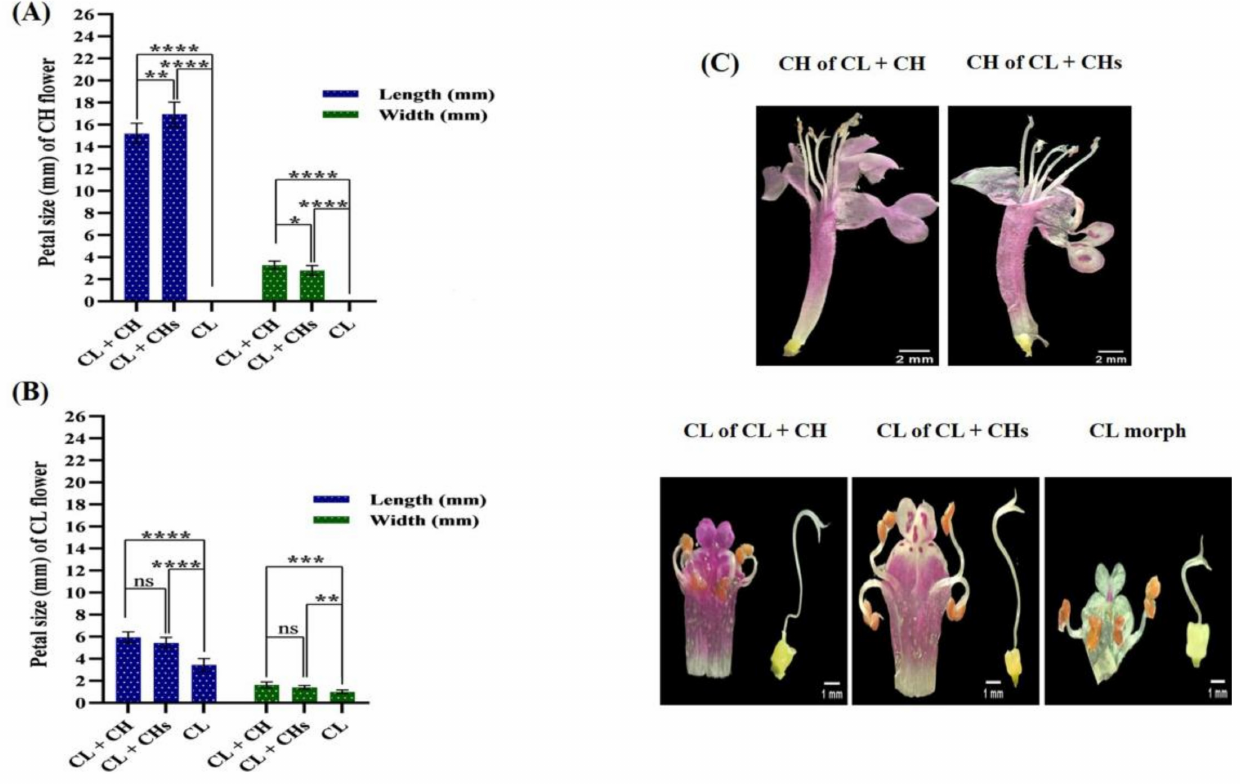
Figure 4. Petals features in the three morphs ( A , B ) Petal size of the different flowers ( C ) Heterostyly in the CL and CH flowers/morph. p value: * ≤ 0.05, ** ≤ 0.01, *** ≤ 0.001 and **** ≤ 0.0001. ns: not